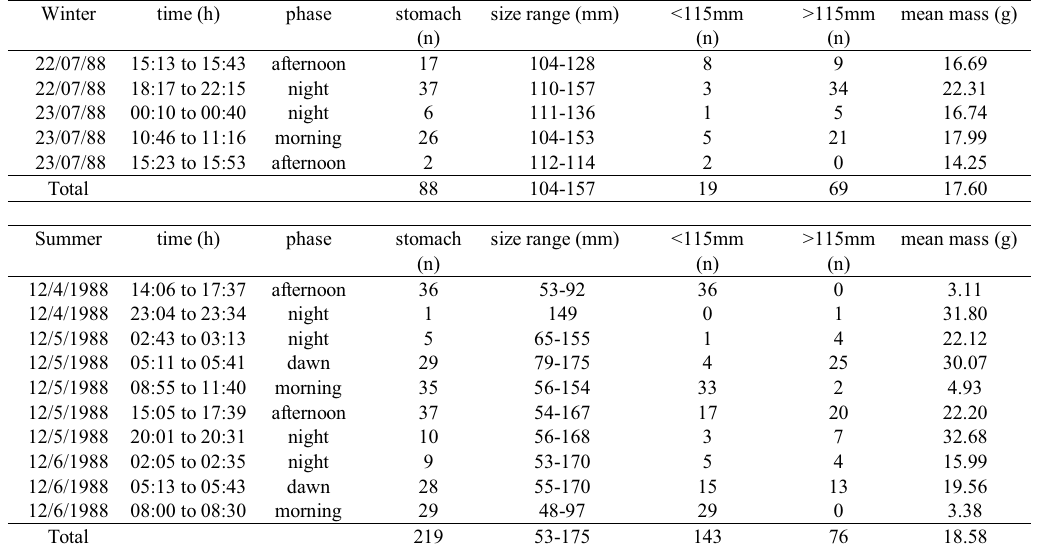
Table 1. Sampling information for Trachurus lathami from Brazilian shelf off